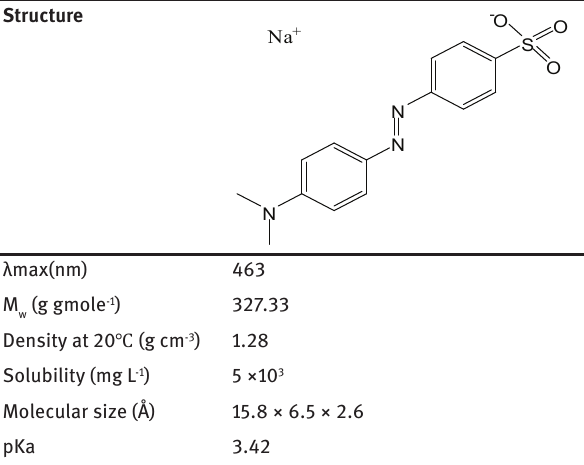
Table 1: Chemical structure and characteristics of methyl